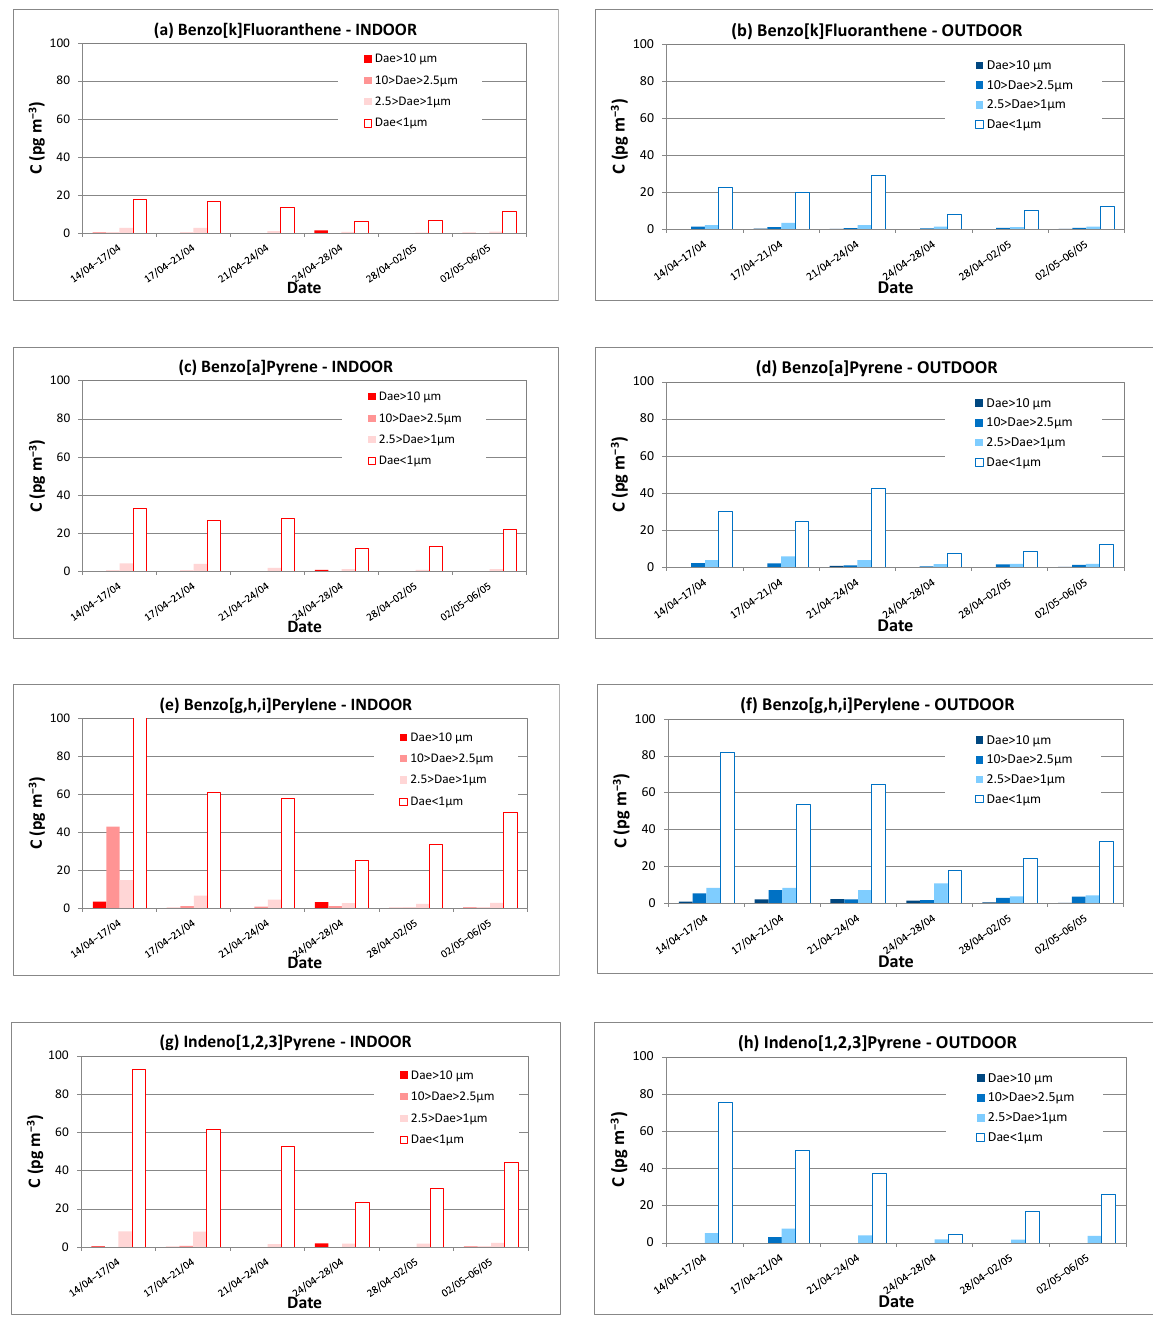
Figure 6. Indoor and outdoor concentrations (pg m − 3 ) of PAHs with five or six rings measured in 2014 vs. time and particle size. ( a ) Benzo[k]Fluoranthene, indoors; ( b ) Benzo[k]Fluoranthene, outdoors; ( c ) Benzo[a]Pyrene, indoors; ( d ) Benzo[a]Pyrene, indoors; ( e ) Benzo[g,h,i]Perylene, indoors; ( f ) Benzo[g,h,i]Perylene, outdoors; ( g ) Indeno[1,2,3]Pyrene, indoors; ( h ) Indeno[1,2,3]Pyrene, outdoors.